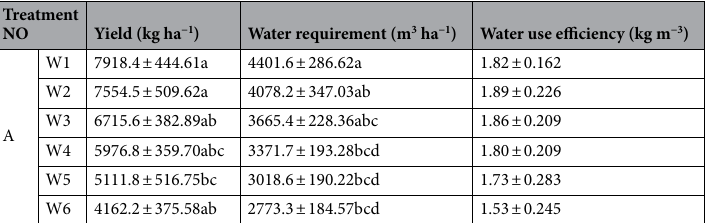
Table 4. Significance of differences of both rice grain yield and water requirement under soil water deficit (Duncan). The actual soil moisture content of the field was determined as a percentage of field capacity(θ), reflecting the degree of soil water deficit. In group A, WI:100% of field capacity; W2:90–100% of field capacity; W3:80–90% of field capacity; W4:70–80% of field capacity; W5:60–70% of field capacity; and W6:50–60% of field capacity. In group B, soil moisture deficit conditions were applied at different growth stages. W7: a filling stage deficit (70–80% of field capacity); W8: a flowering stage deficit (70–80%); W9: a booting stage deficit (70–80%); and W10: a tillering stage deficit (70–80%). The relative soil water content during the other growth stages was maintained at 80–90% of field capacity. Data in the table was the average and standard error of 3 years. Different letters after data in the table mean significant at 5%